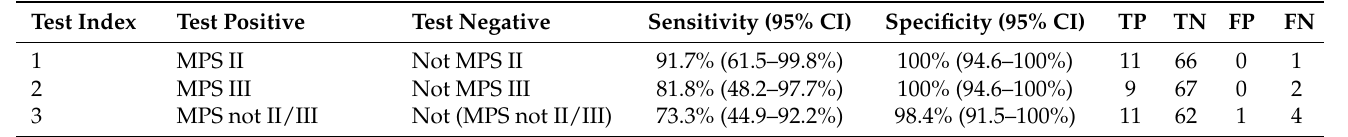
Table 2. Clinical performance of each binary test in the prediction model developed for differential diagnosis of MPS subtypes given urine free GAGome measurements as input. TP: true positive, TN: true negative, FP: false positive and FN: false